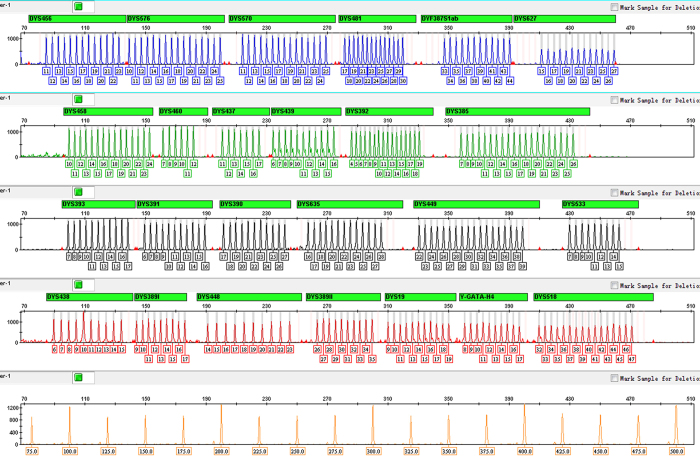
Electropherogram of allelic ladders and internal size standard in the STRtyper-27 system.The four dye panels for allelic ladders correspond to (from top to bottom) 6FAM (blue), HEX (green), TAMRA (yellow), ROX (red) dye-labeled peaks. The haplotype is shown with the allele number displayed underneath each peak. The fifth panel reserved for internal size standard labels an orange dye: SIZE500 (a total of eighteen fragments: 75, 100, 125, 150, 175, 200, 225, 250, 275, 300, 325, 350, 375, 400, 425, 450, 475 and 500 bp).